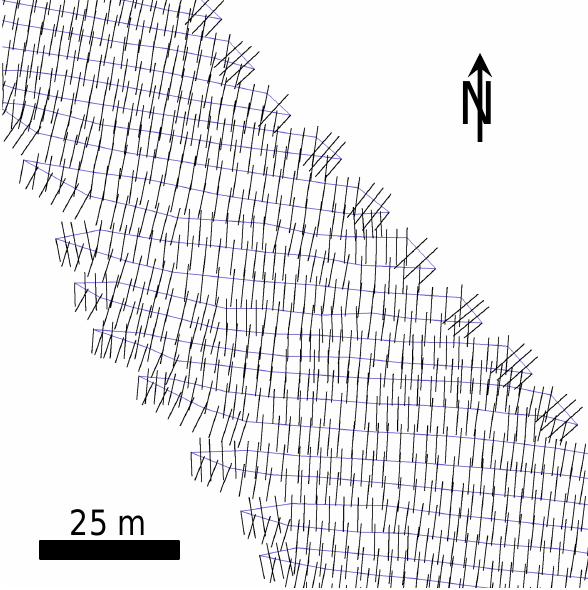
Fig. 6. The spatial alignment of 2-D cross sections (black) was derived from the spatial orientation of stacker trajectories